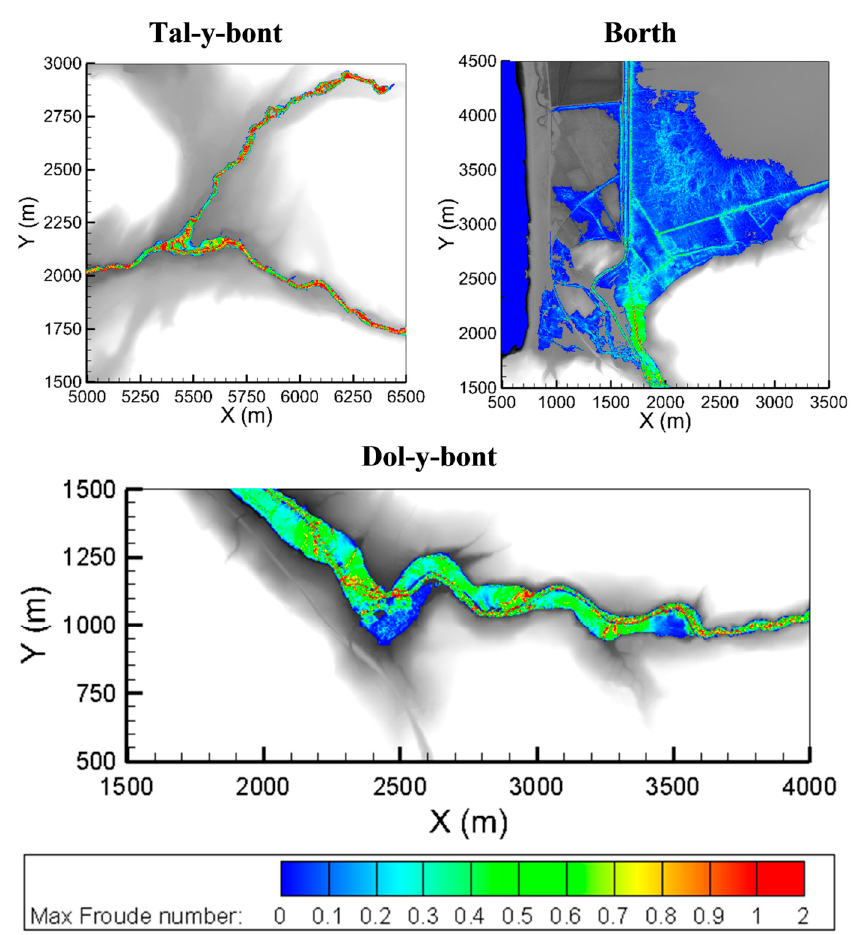
Figure 7. Predicted maximum Froude numbers around Tal-y-bont, Dol-y-bont and Borth.